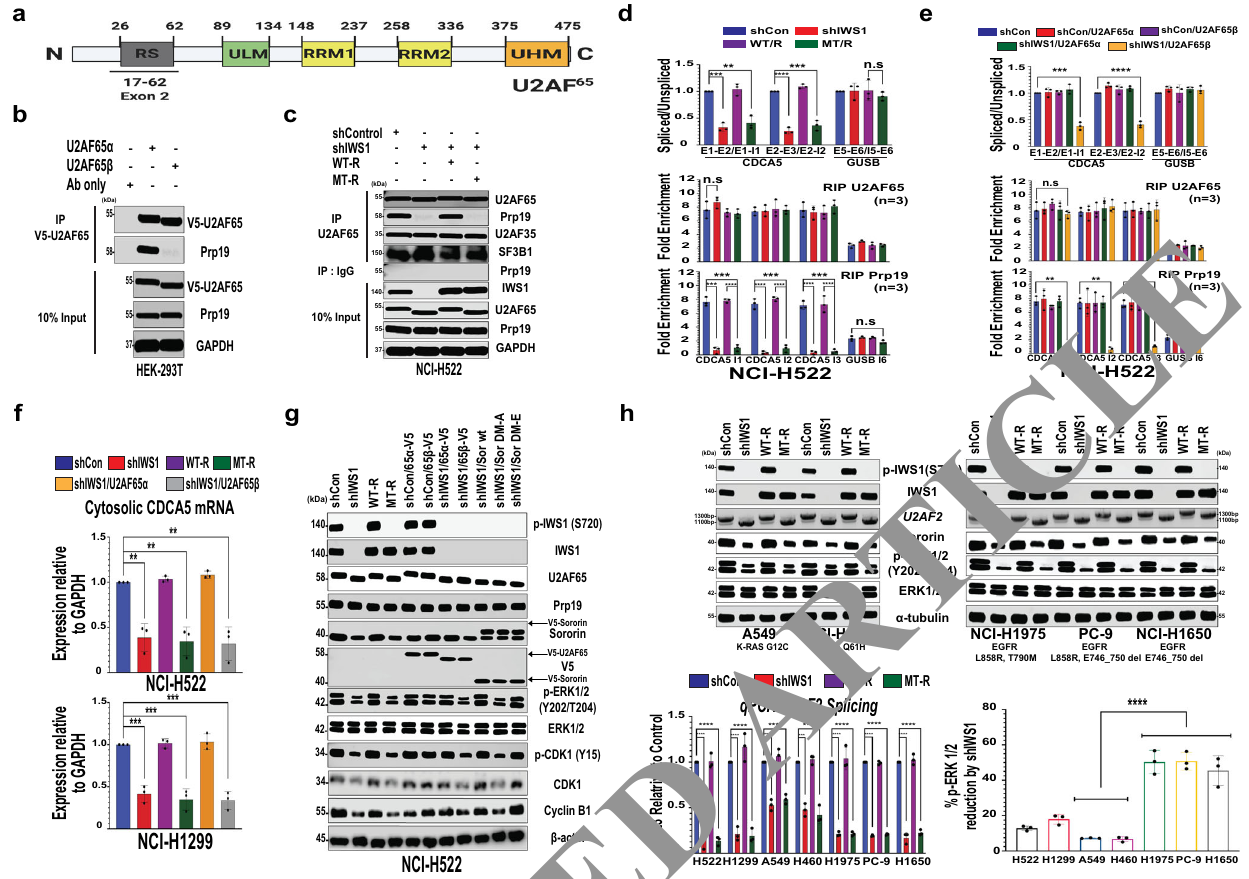
Fig. 5 IWS1 phosphorylation controls the CDCA5/ERK phosphorylation feedback loop, through U2AF2 alternative RNA splicing. a Functional domain composition of U2AF65. Numbers mark the domain boundaries. Exon 2 encodes the RS domain. b HEK-293T cells were transduced with the V5-tagged splice variants of U2AF2 , encoding V5-U2AF65 α and V5-U2AF65 β . Anti V5-U2AF65 immunoprecipitates and input lysates were probed with the indicated antibodies. c Anti-U2AF65, anti-IgG mouse isotype control immunoprecipitates and input lysates of NCI-H522 cells transduced with the indicated constructs were probed with antibodies, as shown. d (Upper panel) The ratio of spliced to unspliced CDCA5 and GUSB (control) RNAs was measured in the indicated NCI-H522 cells by qRT-PCR. (Middle and Lower panels) RIP assays of U2AF65 and Prp19 in the same cells. Anti-U2AF65 or anti-Prp19 IP, vs IgG control IP were used to calculate the mean fold binding enrichment in the indicated RNA regions ±SD. Primers listed in Supplementary Table 2. Primer location in Supplementary Fig. 7b. e (Upper panel) shIWS1 rescue by U2AF65 α and U2AF65 β . Spliced/unspliced RNA ratios of CDCA5 and GUSB, measured by qRT-PCR, as in Fig. 5d. (Middle and Lower panels) RIP assays of U2AF65 and Prp19 in the same cells. Data presented as in fi gure 5d. f Cytosolic CDCA5 mRNA levels in the indicated shIWS1-transduced cells were rescued by IWS1 and U2AF65 α , as determined by q-RT-PCR. GAPDH- normalized CDCA5 mRNA ±SD. Validation of fractionation in Supplementary Fig. 7e. g Lysates of NCI-H522 cells, transduced with the indicated constructs, were probed with antibodies, as shown. DM-A and DM-E are the S79/S209AA and S79/S209EE Sororin mutants, respectively. h (Upper panels) Lysates of KRAS and EGFR mutant cell lines, transduced with the indicated constructs, were probed with antibodies as shown. RT-PCR, using U2AF2 exon 1 and 3 primers. (Lower Left panel) Bars show the qRT-PCR-determined U2AF2 E2/E3 ratios in NCI-H522 and NCI-H1299 cells, and in the KRAS and EGFR mutant cell lines, relative to the shControl±SD. (Lower Right panel) Bars show the shIWS1-induced percent reduction of ERK-phosphorylation in the same cell lines, normalized to tubulin ± SD. EGFR mutant and non-mutant cells were compared, using a one-way ANOVA. All assays were in triplicate, on three biological replicates. n.s non-signi fi cant, * p < 0.05, ** p < 0.01, *** p < 0.001, **** p < 0.0001 (one-sided unpaired t spliced and unspliced CDCA5 RNA in shControl, shIWS1, shIWS1/WT-R, and shIWS1/MT-R NCI-H522 and NCI-H1299 cells. The RNA splicing of GUSB , does not depend on the U2AF65 interaction with Prp19 36 , and it was used as the negative control. The results con fi rmed that whereas the RNA splicing of CDCA5 is impaired in both the shIWS1 and shIWS1/MT-R cells, the RNA splicing of GUSB is not (Fig. 5d, Supplementary Fig. 7b and c, upper panels). More important, the splicing defect was rescued by U2AF65 α but not by U2AF65 β (Fig. 5e, Supplemen- tary Fig. 7d, upper panels). To determine how IWS1 phosphorylation regulates CDCA5 RNA splicing, we performed RNA immunoprecipitation (RIP) experiments in shControl, shIWS1, shIWS1/WT-R, and shIWS1/